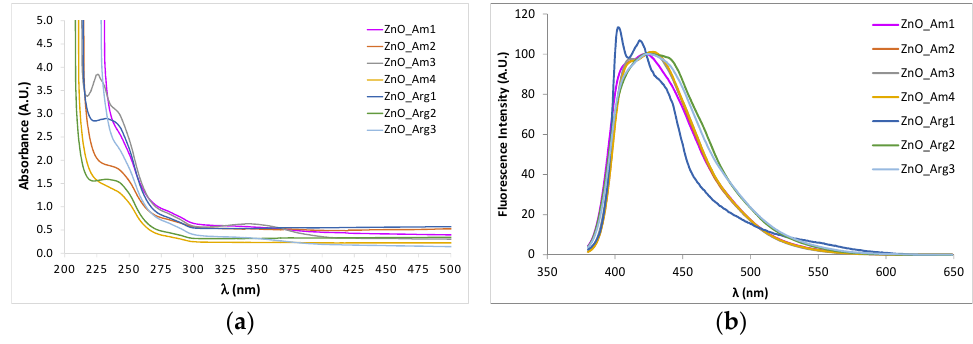
Figure 4. UV-Vis ( a ) and fluorescence ( b ) spectra of ZnO NPs prepared under various conditions